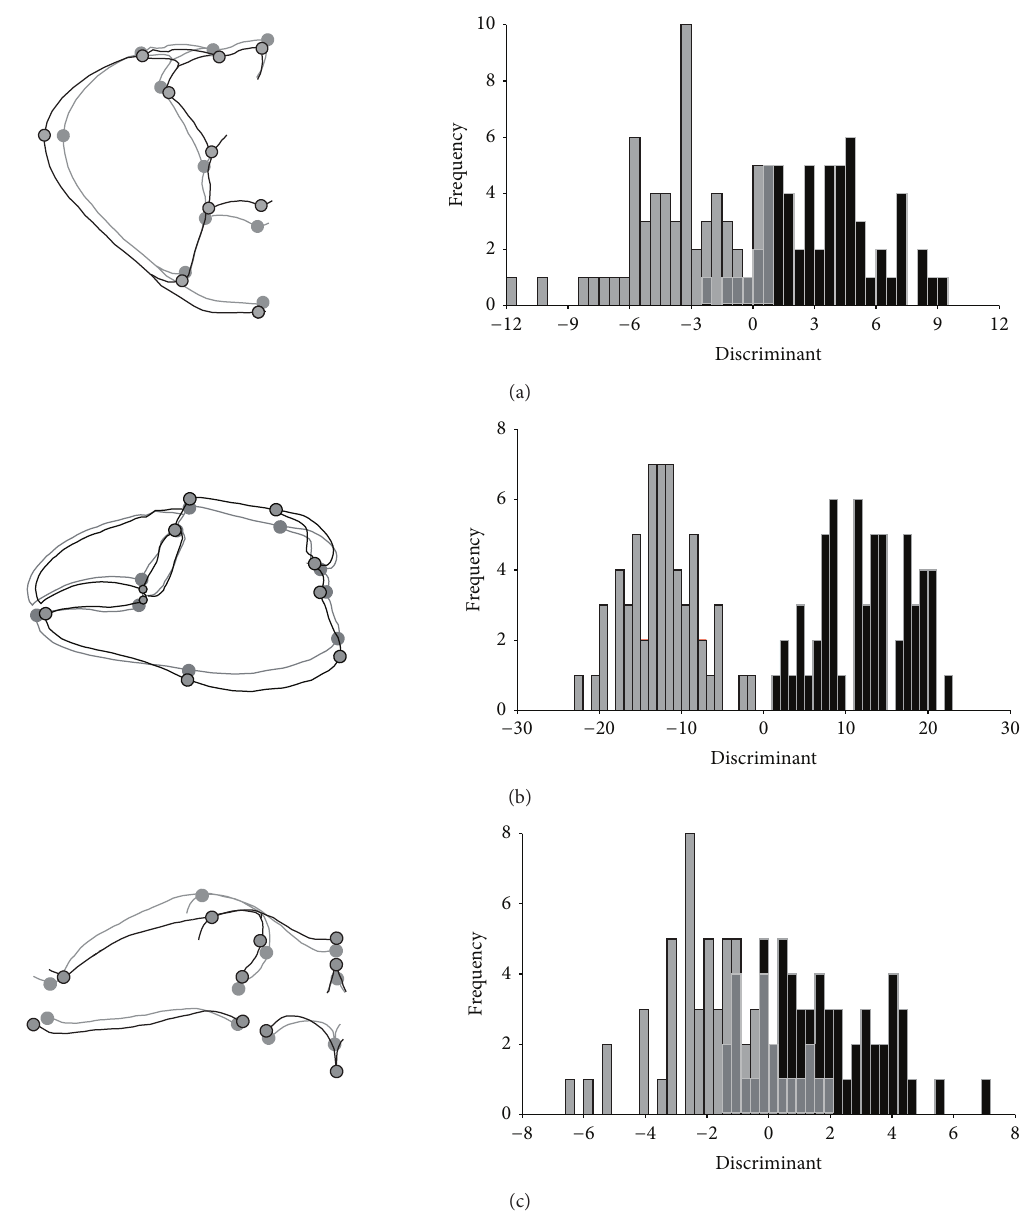
Figure 2: Ucides cordatus (Linnaeus, 1763): comparison of body shape from outline drawing; obtained frequencies from Discriminant function analysis. Deviation between male and female correspondent landmarks, in each structure, represents the vector displacement (deformation grid). (a) Dorsal area of carapace—C; (b) outer face of major cheliped—MC; and (c) anterior region of cephalothorax—AR; gray = female and black =